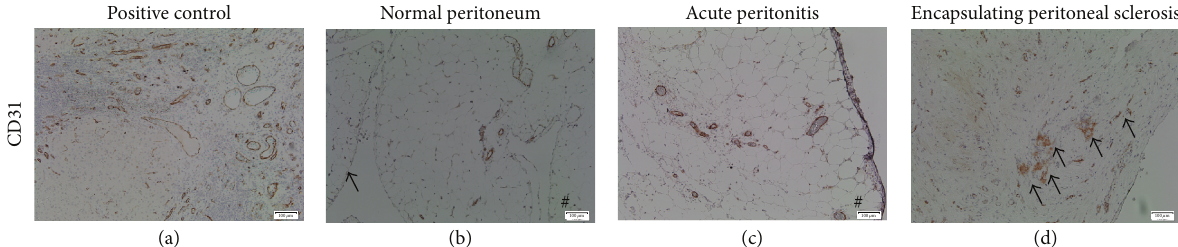
Figure6:Representativephotomicrographsdemonstratinghistopathologicaldataofendothelialcellsmarkerexpressioninparietalperitoneal tissues biopsy using immunostaining of CD31 (a). Positive control of immunostainings for used antibodies (internal controls) (a), control: normal peritoneum (b), case of acute peritonitis (control 3; c), and case 1 of encapsulating peritoneal sclerosis (EPS) (d). As compared with normal and acute peritonitis cases, increases in endothelial CD31 expression identifying nonlymphatic vascular network were localized in the deep areas of peritoneum and reflected increased vessels density. Immunoperoxidase staining counterstained with hematoxylin. Original magnification: (a–d) ×